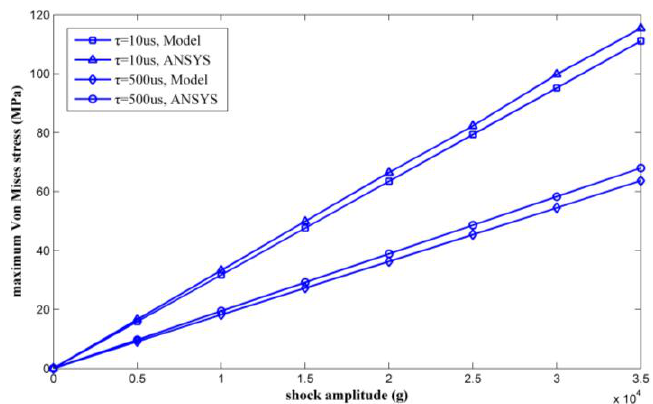
Figure 10. Maximum Von Mises equivalent stress by ANSYS and the model versus shock load amplitude.